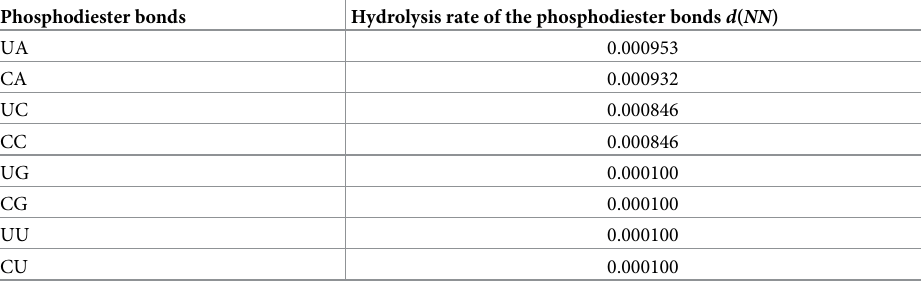
Table 2. Hydrolysis rates of the phosphodiester bonds ( dNN ) used in the Scenario